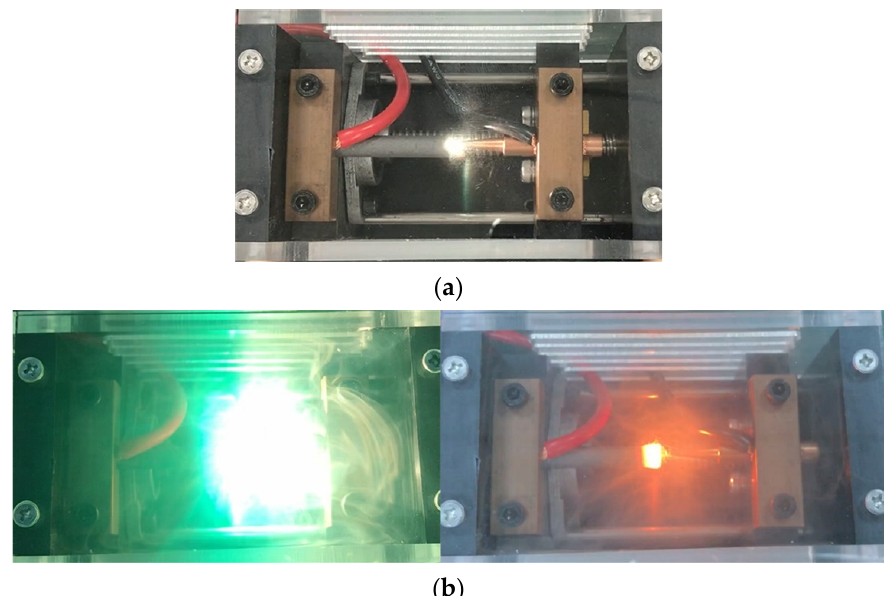
Figure 25. Arc pictures. ( a ) Short arcs and sparks; ( b ) Arc in shunt mode.